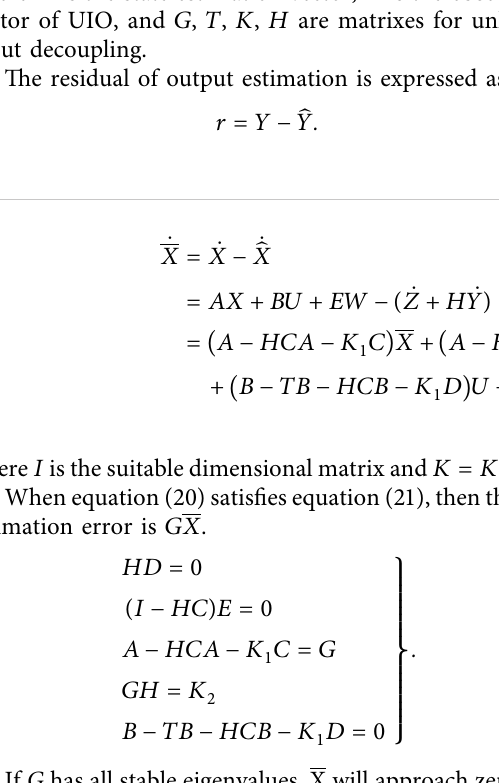
Figure 9: Structure of